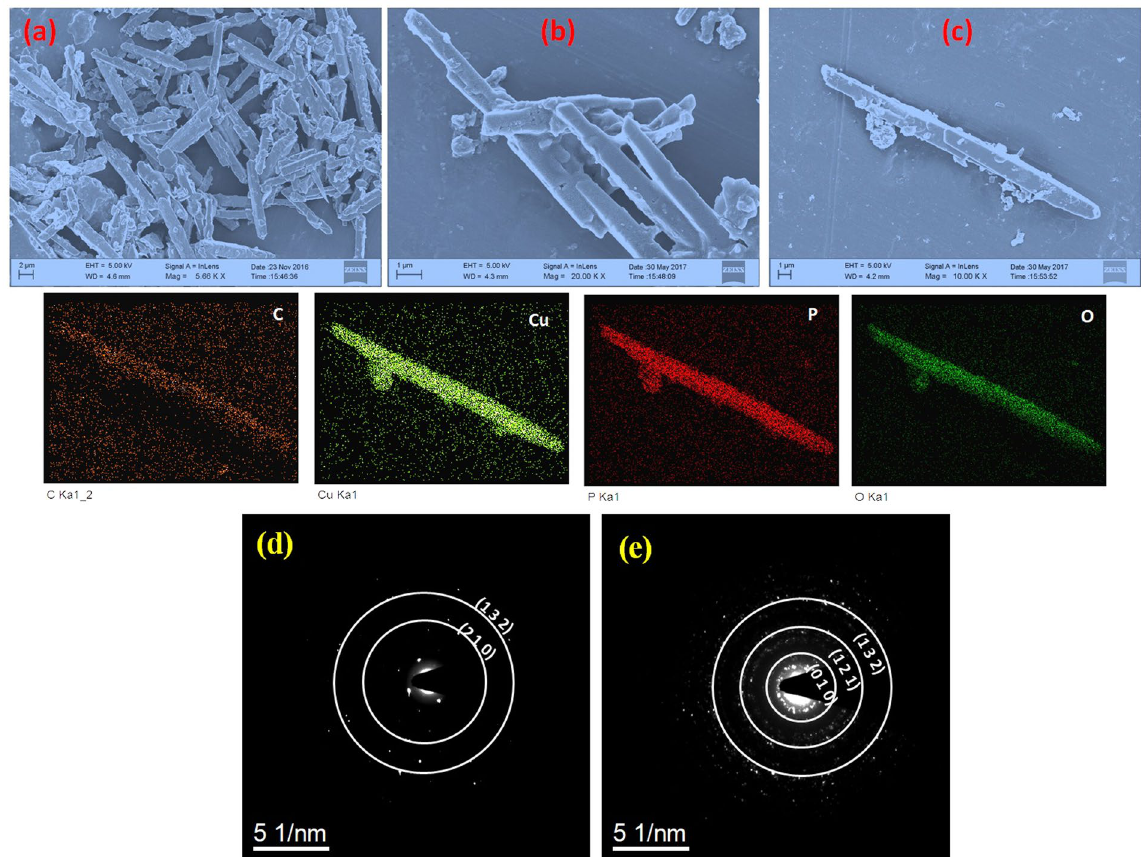
Figure 4. FE-SEM morphological analysis of ( a ) Cu 3 (PO 4 ) 2 -PA, ( b ) 8RGO-Cu 3 (PO 4 ) 2 -PA and ( c ) FE-SEM micrograph of single rod structure in 8RGO-Cu 3 (PO 4 ) 2 -PA along with its elemental mapping. SAED patterns of ( d ) Cu 3 (PO 4 ) 2 -PA ( e ) 8RGO-Cu 3 (PO 4 ) 2